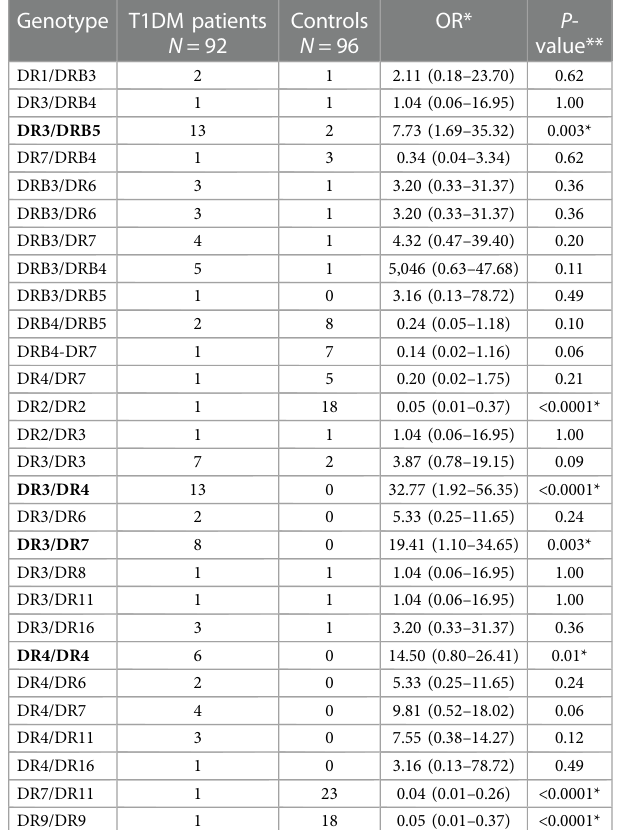
TABLE 5 Frequency of HLA DR genotypes in Kuwaiti T1DM patients and controls. The genotypes were determined by using PCR-SSP method (Dynal kits, Oslo, Norway) as described in Materials and Methods. Genotype T1DM